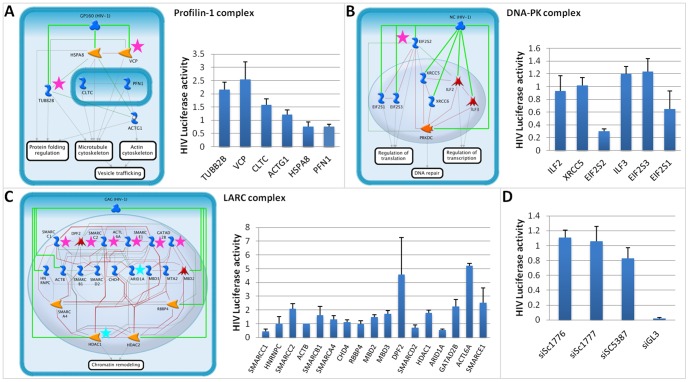
Selected complexes and RNAi screening results.(A) Profilin-1 complex interacting with GP160. (B) DNA-PK-Ku-eIF2-NF90-NF20 complex interacting with NC. (C) LARC complex interacting with Gag. Interactions within the complex represent functional interactions from HumanNet (green), manually curated interactions from the Metabase resource (gray) or from both sources (red). Pink vs. turquoise stars correspond to proteins that were confirmed in our RNAi validation screen vs. previous screens, respectively. Orange nodes are kinases, red transcription factors, blue are binding proteins as classified in Metabase. The bar plots show the HIV luciferase activity of the sample normalized by the HIV luciferase activity of control siRNAs. (D) HIV luciferase activity for three non-targeting siRNAs (positive controls) and luciferase-targeting siGL3 (negative control) performed simultaneously with siRNA transfections shown in A, B, and C.